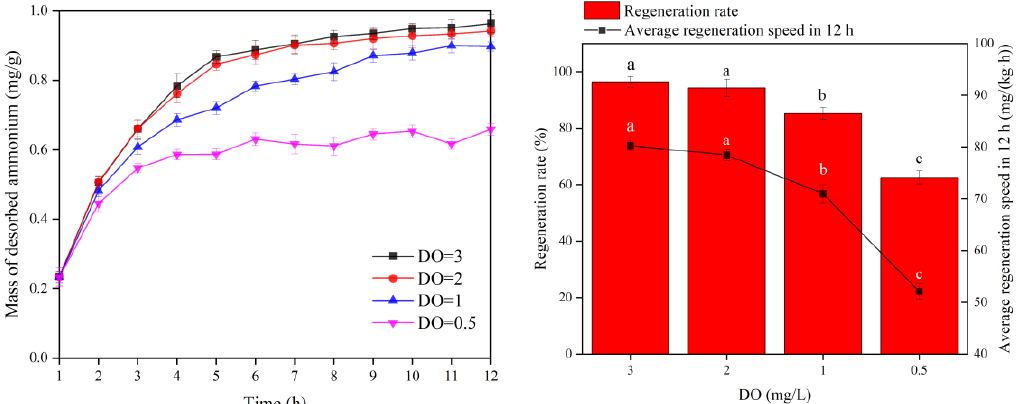
Figure 7. Biological regeneration performance of bio-ceramsite in different DO levels. Vertical bars represent ± SD of the means ( n = 3). In bar chart, the different superscript letters mean significantly different (Tukey’s post hoc test, p < 0.05).